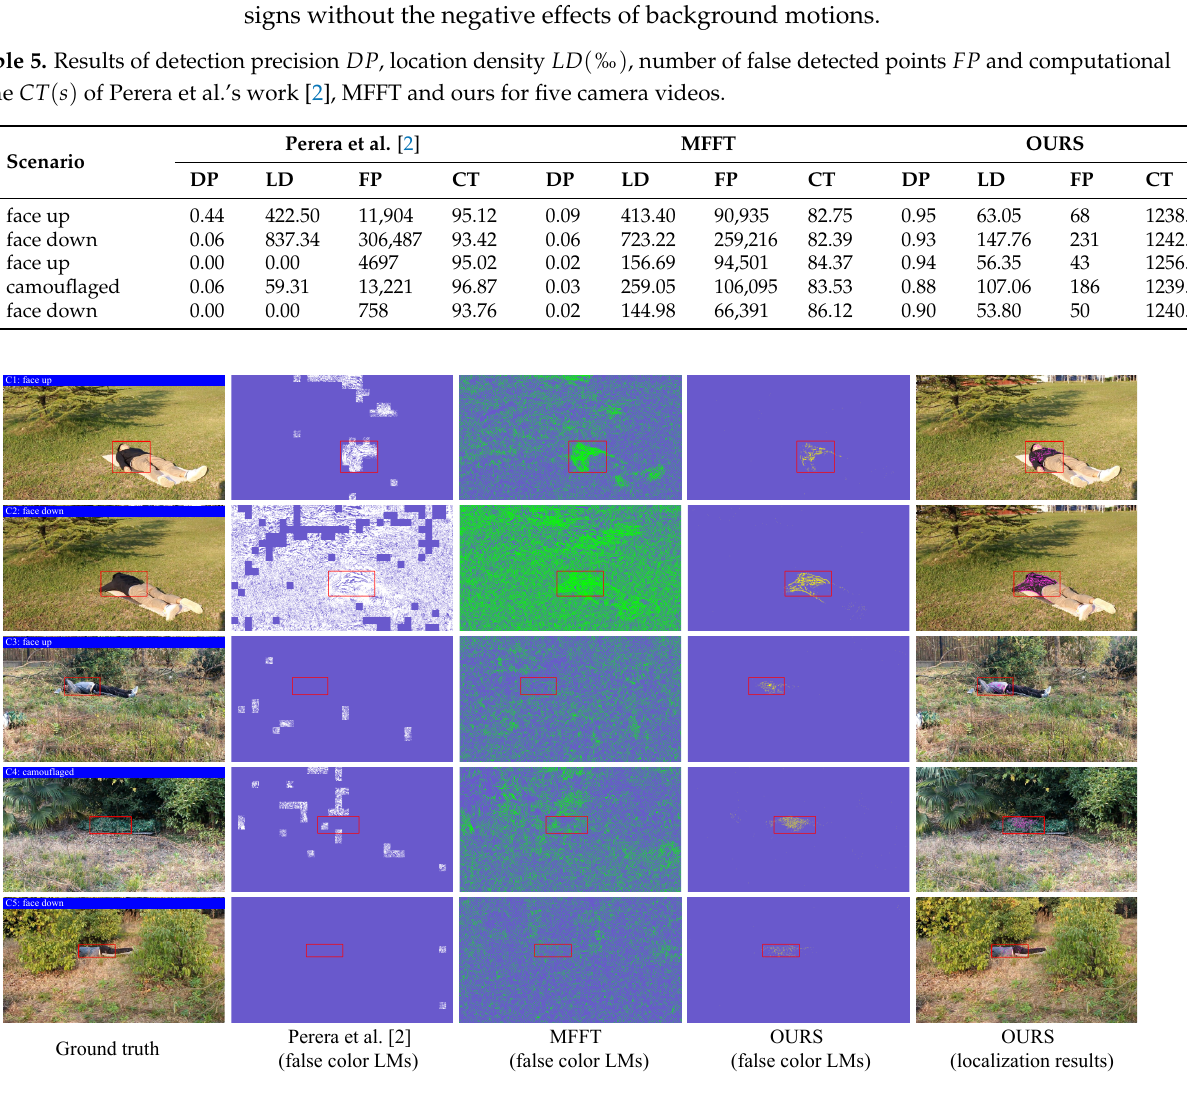
Figure 7. False color location maps (LMs) of Perera et al.’ work [2], MFFT and ours, and our localization results for five camera